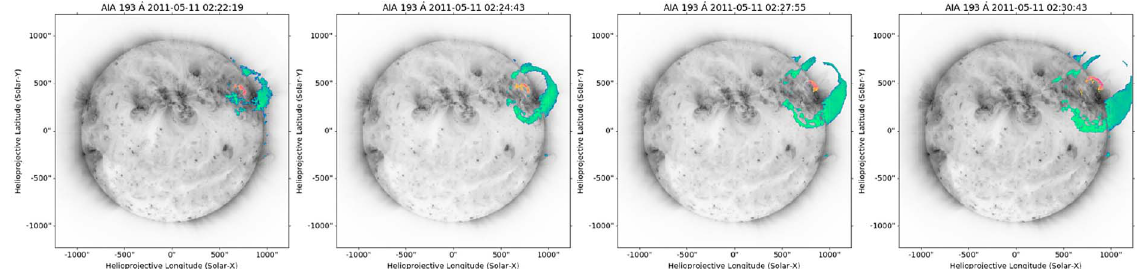
Fig. 5. Combined tracking of May 11, 2011, CBF and the fi lament driving it, with Wavetrack is shown here for three snapshots of the event, separated by approximately 2 min